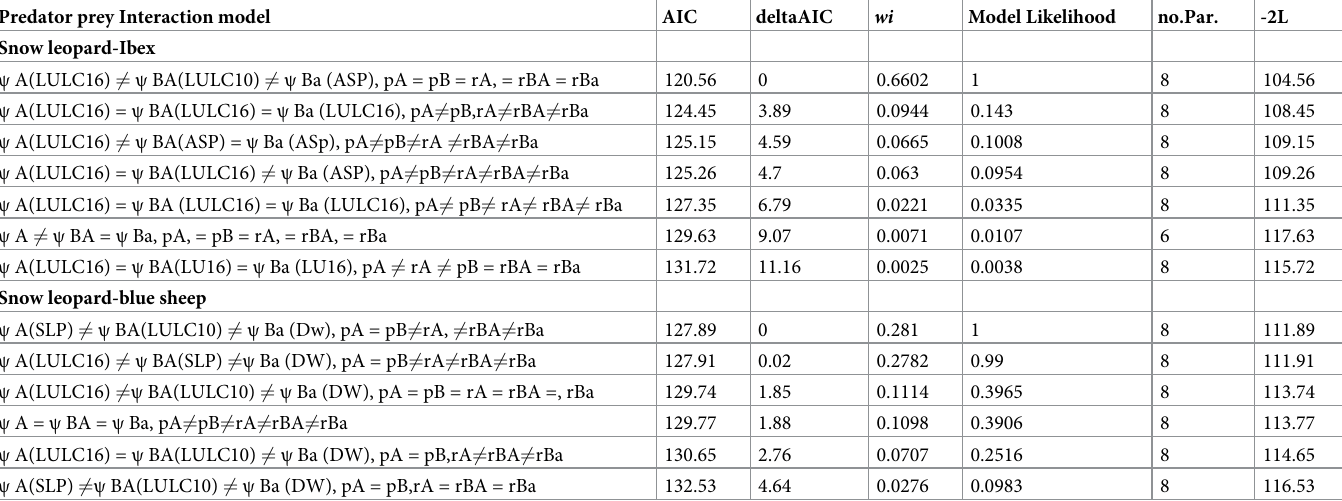
Table 1. Co-occurrence occupancy models used to evaluate the role of predator-prey interactions on the habitat use of predator and prey in Spiti Valley. Predator prey Interaction model AIC deltaAIC wi Model Likelihood